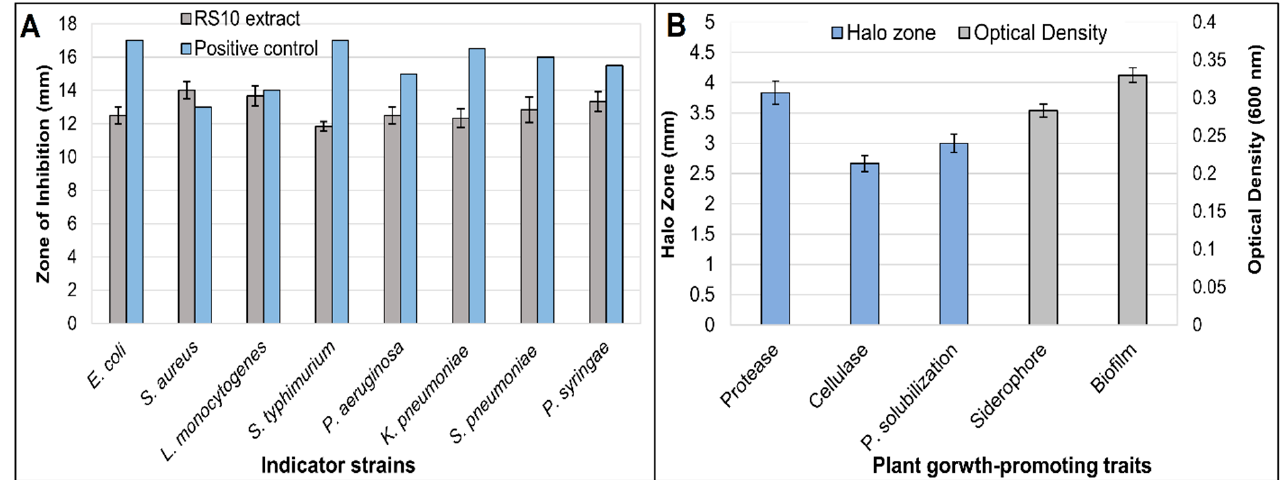
Figure 1. ( A ) Antibacterial activity of culture extract against indicator ATCC strains; ( B ) plant growth-promoting ability of B. subtilis strain RS10. The bar graph represents mean values ± standard deviation of triplicates experiments.